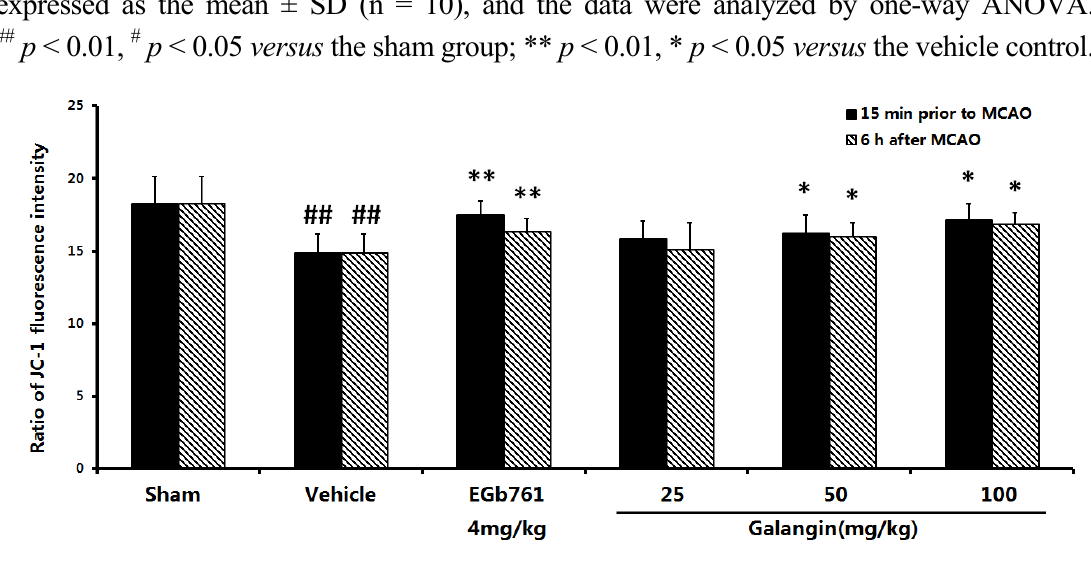
Figure 7. The red/green fluorescence ratio of JC-1 caused by MCAO. EGb761 and galangin were both administered by i.g. 15 min prior to MCAO and 6 h after MCAO. The values